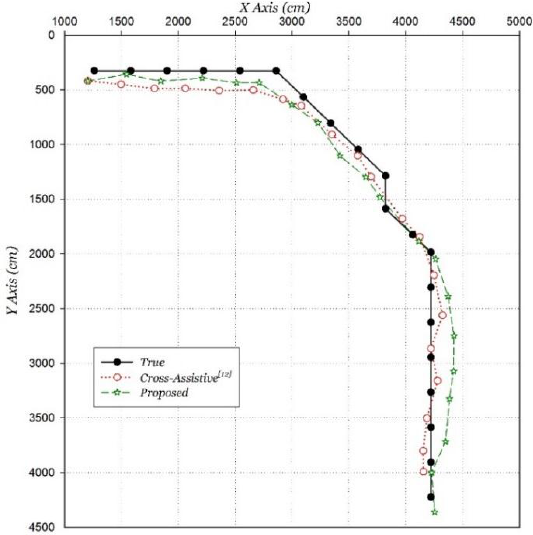
Figure 19. Lateral comparison of proposed algorithm.